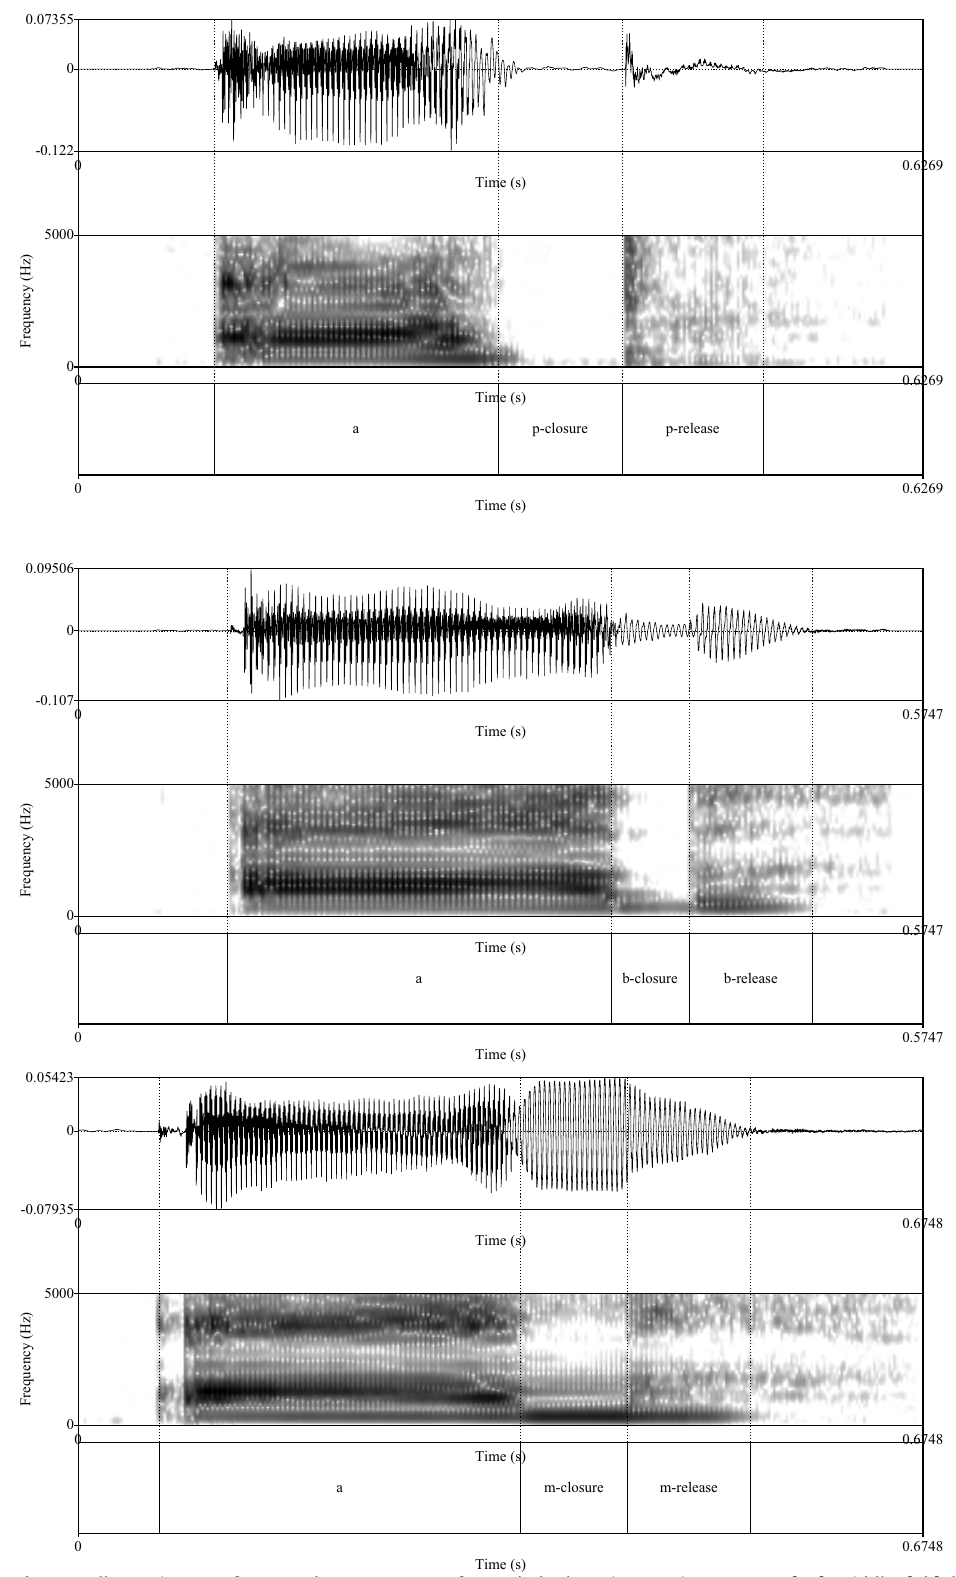
Figure 1: Illustrative waveforms and spectrograms of recorded tokens in Experiment I. Top: [ ɑ p]; middle: [ ɑ b]; bottom: [ ɑ